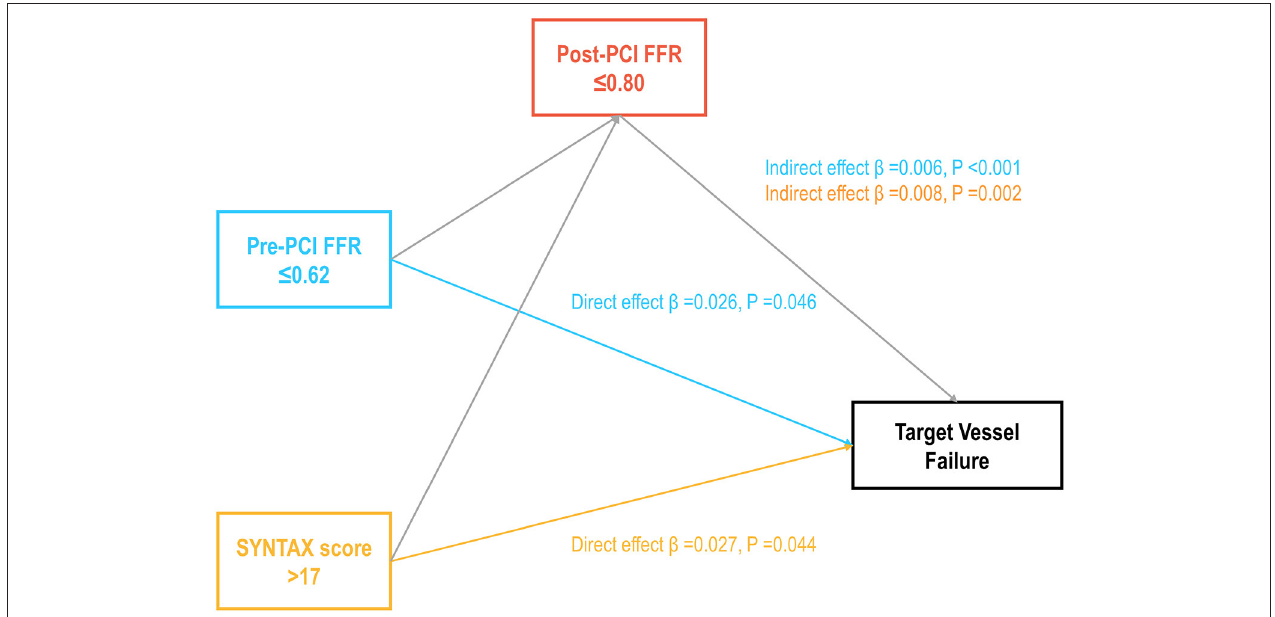
FIGURE 3 | Prognostic implications of ICwRI mediated by residual ischemia. The direct and indirect prognostic effects of ICwRI mediated by residual ischemia are shown. ICwRI included pre-PCI SYNTAX score > 17 and pre-PCI FFR ≤ 0.62. FFR, fractional flow reserve; ICwRI, interaction characteristics with residual ischemia; PCI, percutaneous coronary intervention.